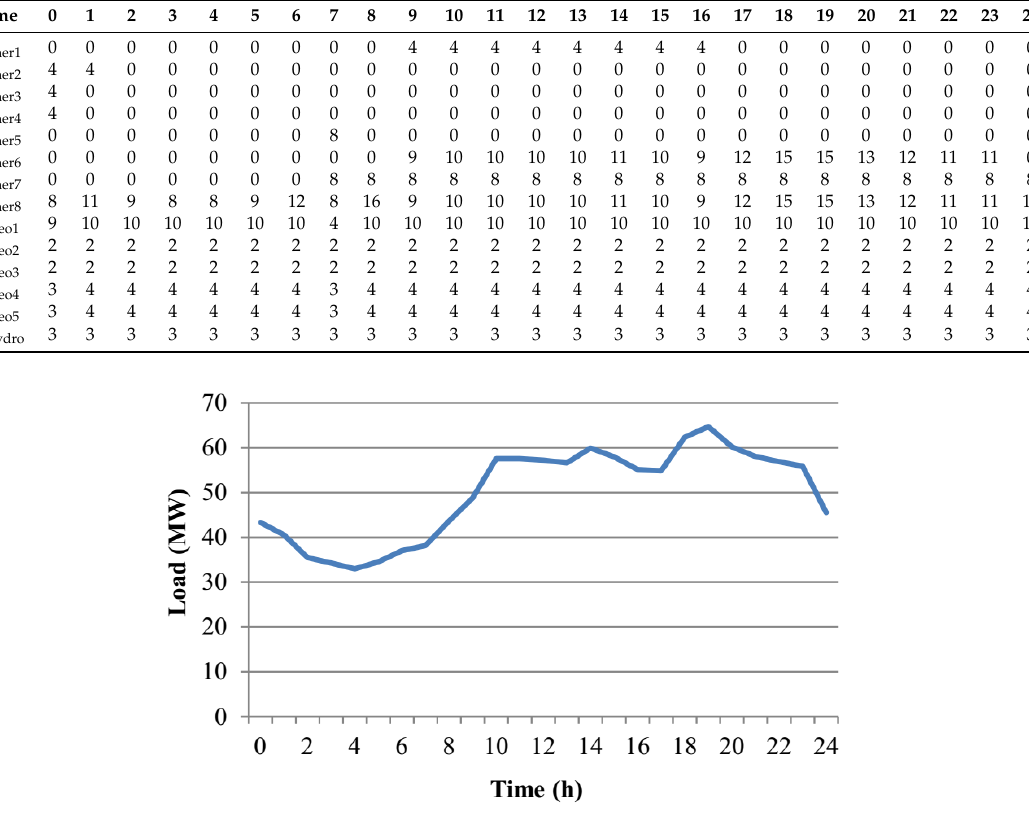
Figure 2. Winter load forecast profile in a single day of 2014.